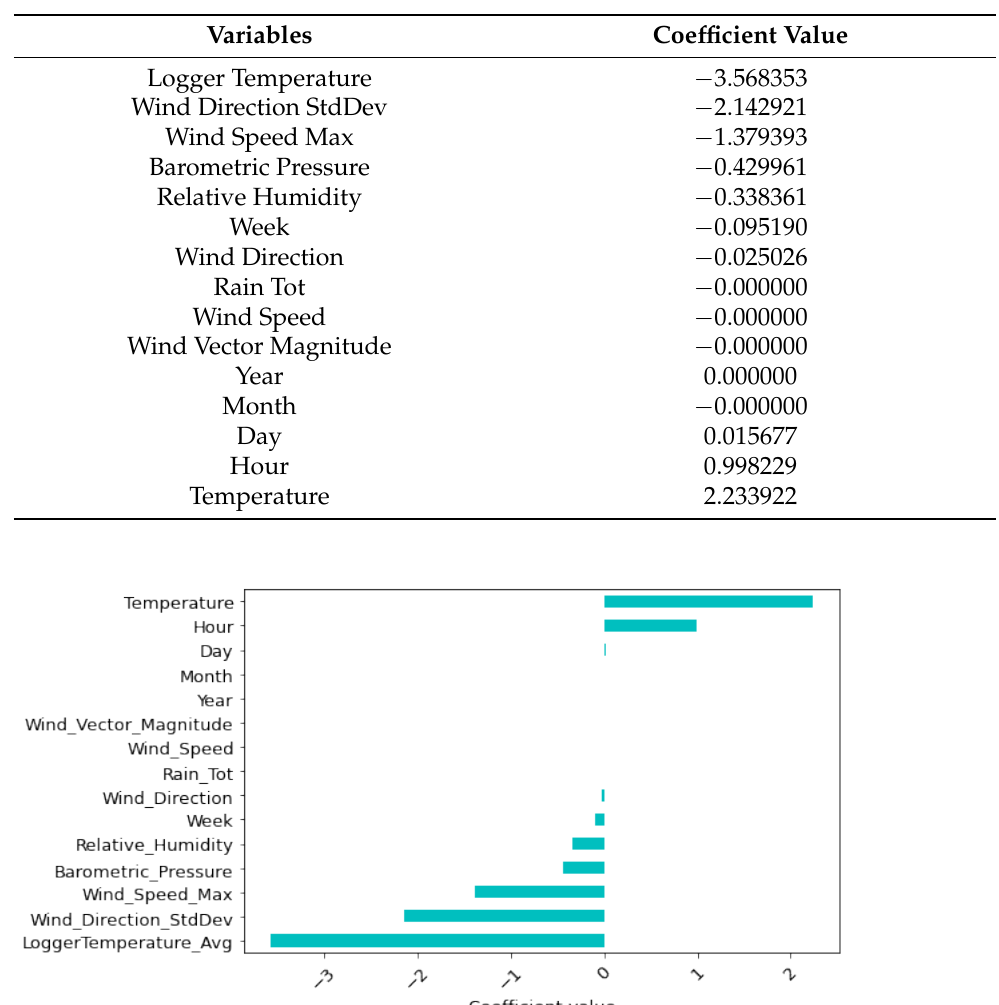
Table 2. Variable coefficient values.